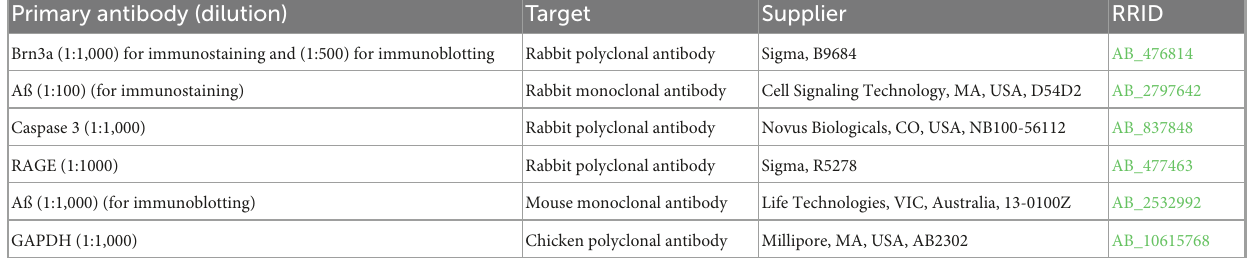
TABLE 2 List of secondary